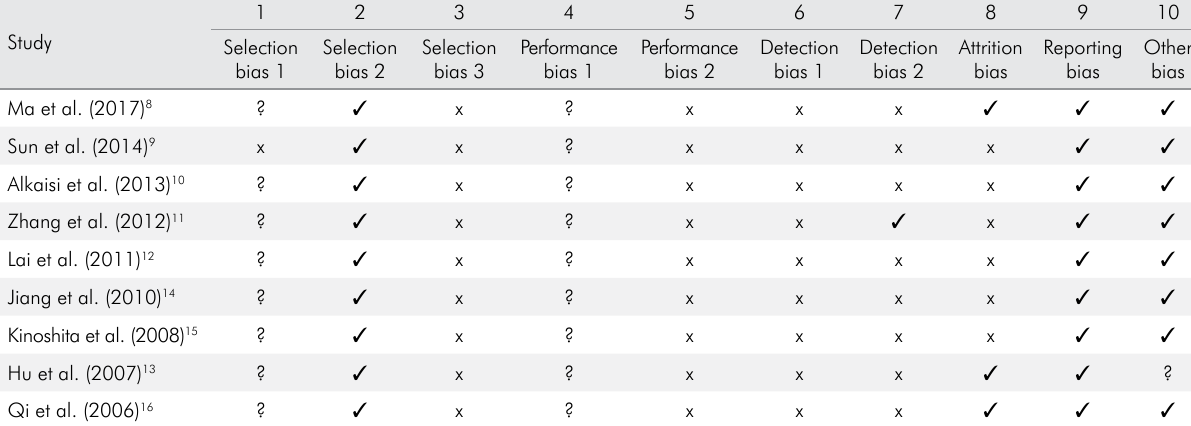
Table 4. Risk of bias in individual studies, assessed using the SYRCLE tool.